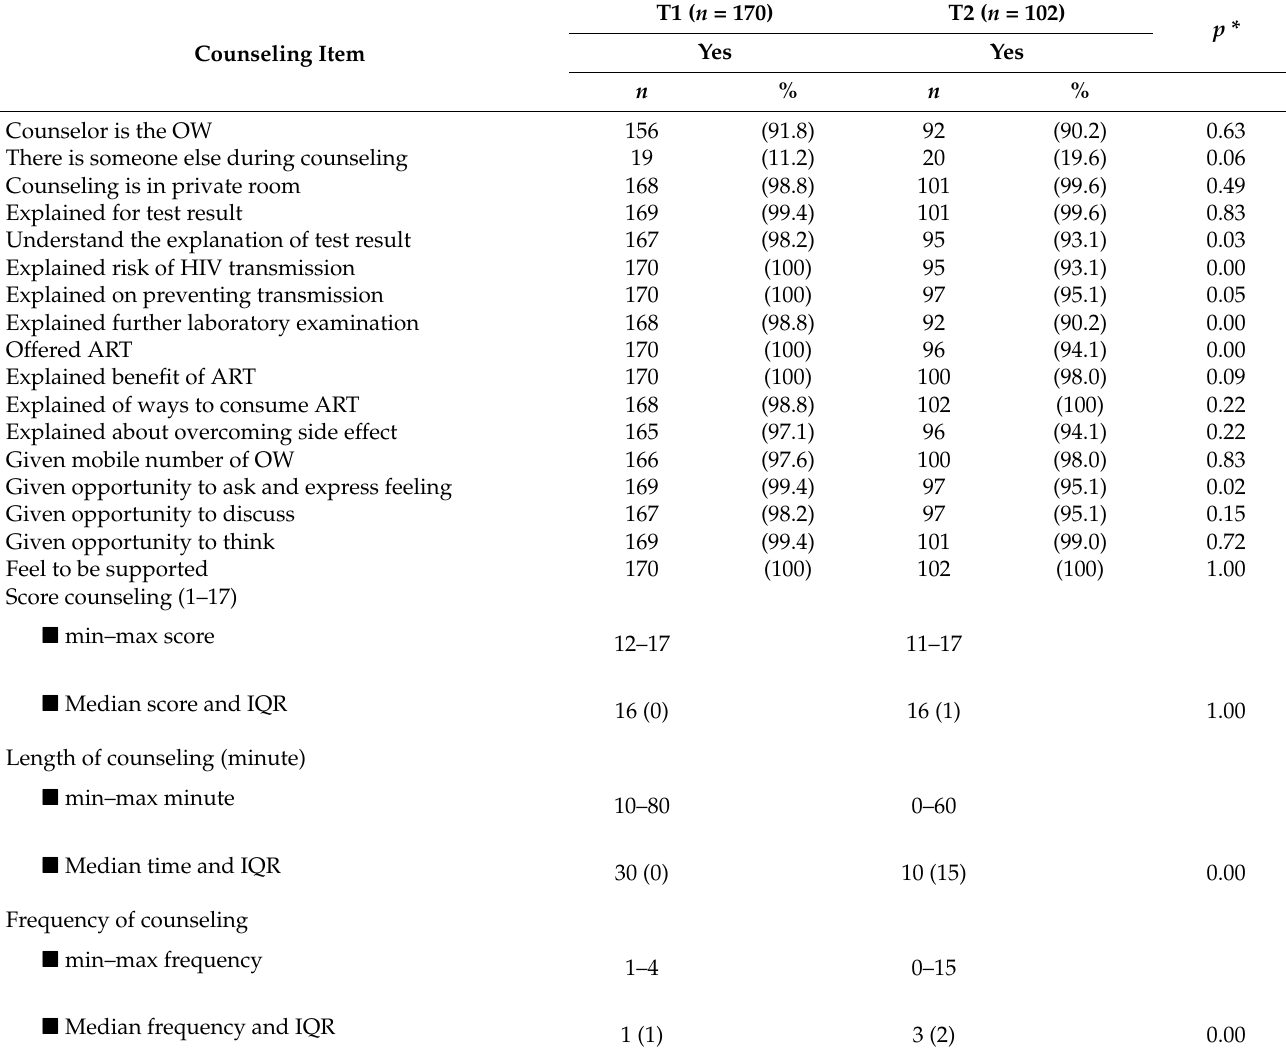
Table 2. Percentage of activities of counseling based on PLHIV evaluation after HIV diagnosis and two to five months after ART